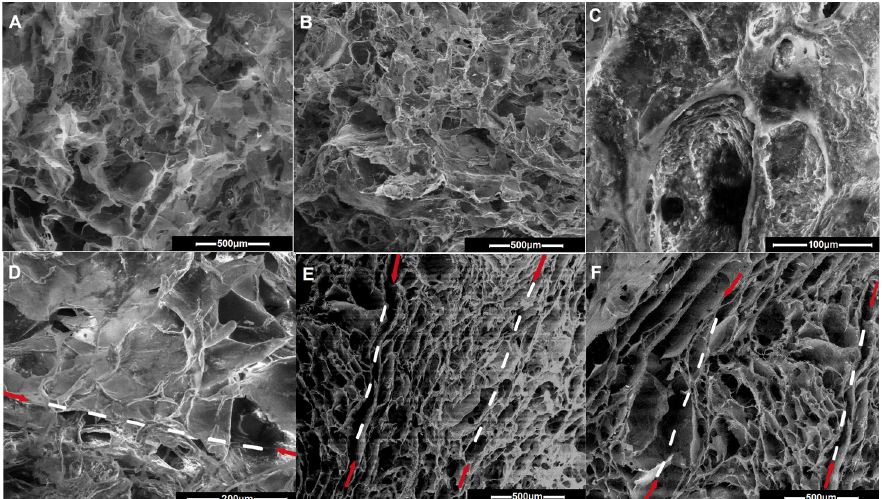
Figure 8. Representative SEM images for the prepared cryogels (mono ‐ , bi ‐ , and trilayered): ( A ) sample 2/CP7, ( B ) and ( D ) bilayered constructs at the interface CH5P15HAp20/CH5P10HAp5, ( C ) sample 3/CH5P15HAp20, ( E ) TL1 trilayered sample (CH10P20HAp20/CH7P10HAp5/CH5P10), and ( F ) TL2 trilayered sample (CH7P10/CH7P10HAp5).